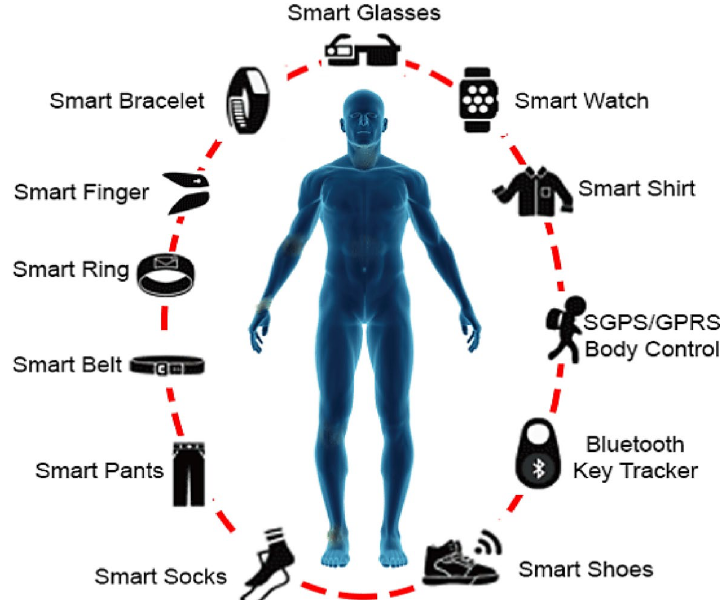
Fig. 2 Example of a wearable